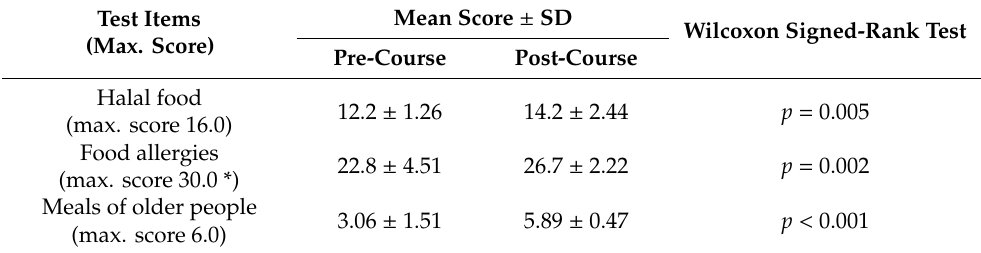
Table 3. Change in knowledge regarding vulnerable people (n = 18).